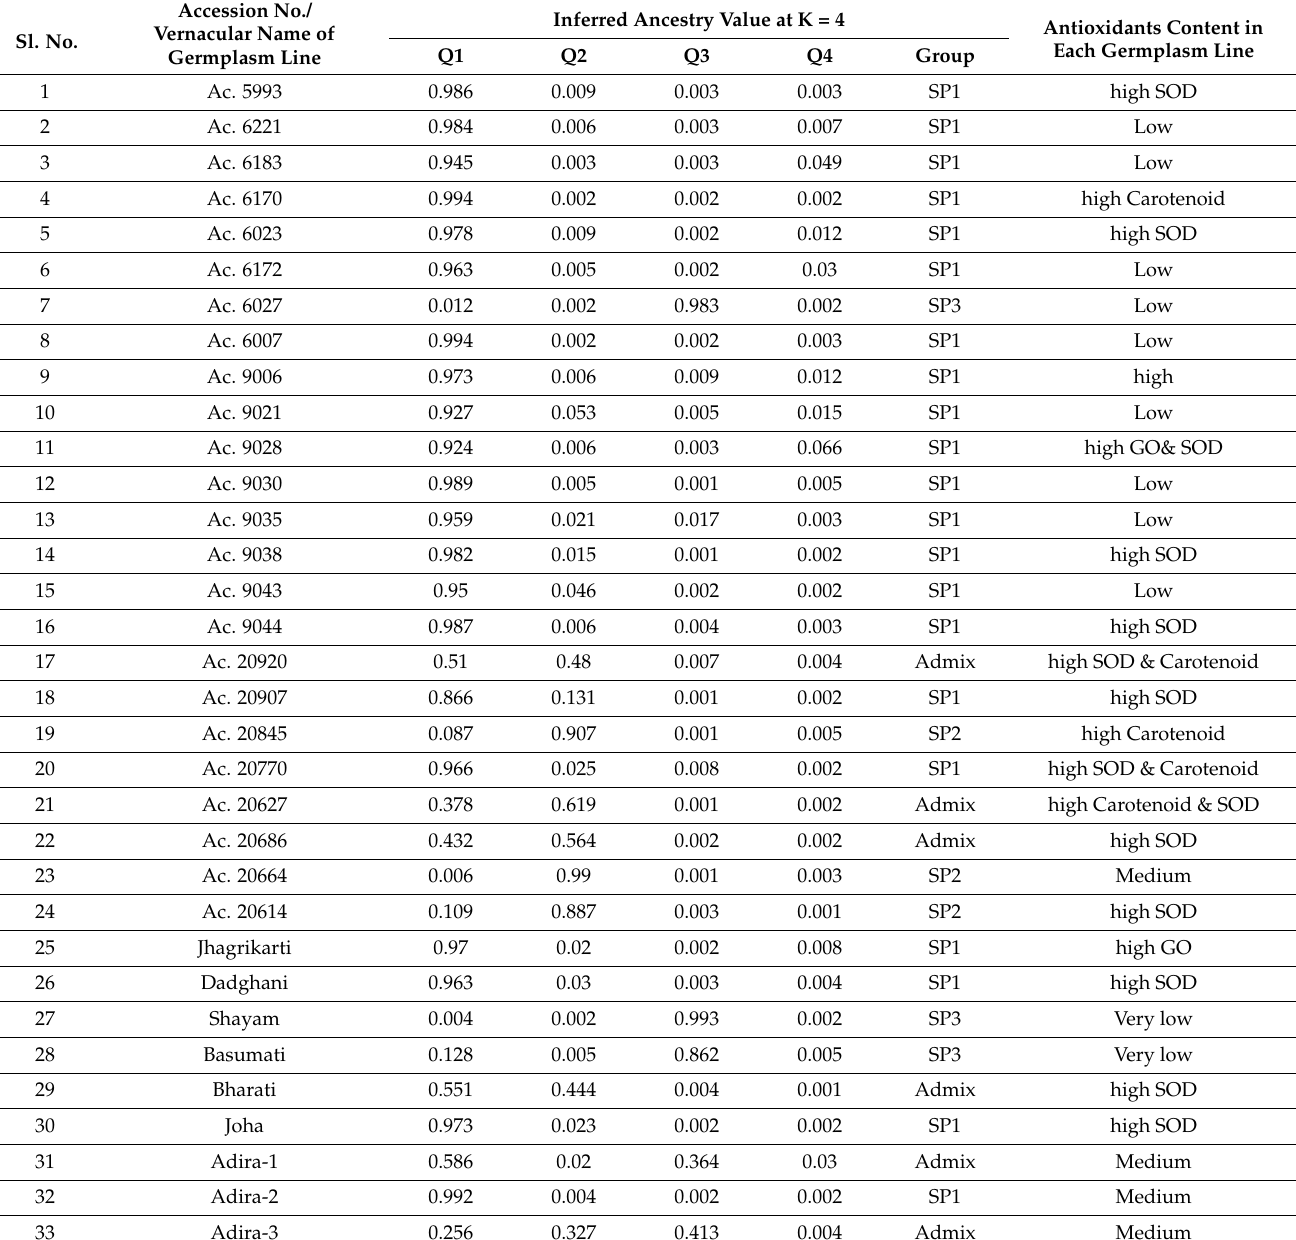
Table 3. The inferred ancestry value and population structure of individual member in the panel population with their antioxidant